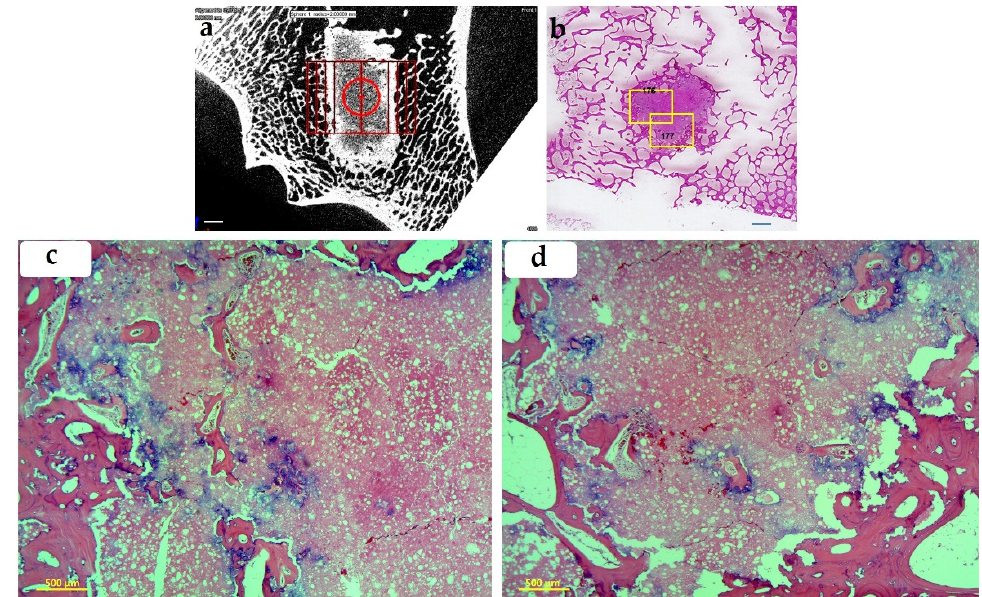
Figure 7. BoneReg-Inject™. ( a ) Micro CT image (scale bar = 2 mm) and ( b ) a histological slide showing BoneReg-Inject™ implant at 13 months postoperative (scale bar = 2 mm). New bone is well integrated with the surrounding trabecular bone. Yellow frames on the histological slide refer to regions in focus in ( c ) (176) and ( d ) (177). In this animal, the micro CT image shows relatively well-developed colonization of mineralized tissue inside the implant. The histological slide indicates trabecular-like neo-osteoid replacing the resolved outer rim of the implant and integrating into the surrounding trabecular bone. ( c , d ) show neo-osteoid replacing the resolved surface of the implant and forming islands scattered inside the mass of the implant. Blue indicates calcification. Samples stained with hematoxylin and eosin.